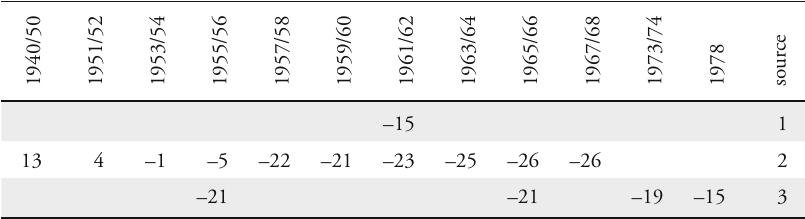
Table 9: Difference in Percentage between Aggregate Income Based on Tax/Official Data and National Accounts Household Income for the Time Period 1940 to 1978 501951 521953 541955 561957 581959 601961 621963 641965 661967 681973 / / / / / / / / / / 1940 /